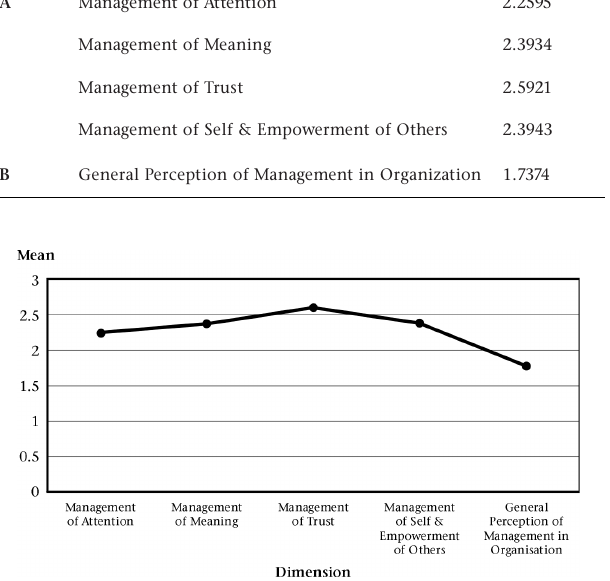
Figure 5: Chart of Total Mean per